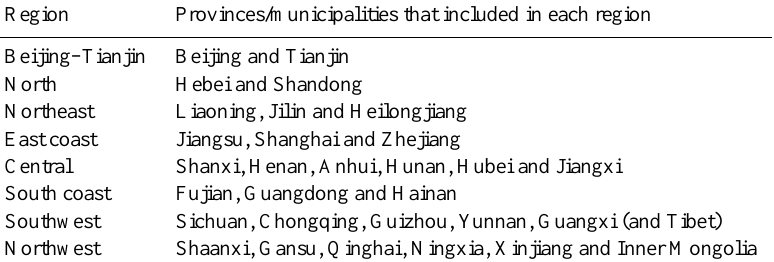
Table A2. Region divisions. Region Provinces/municipalities that included in each